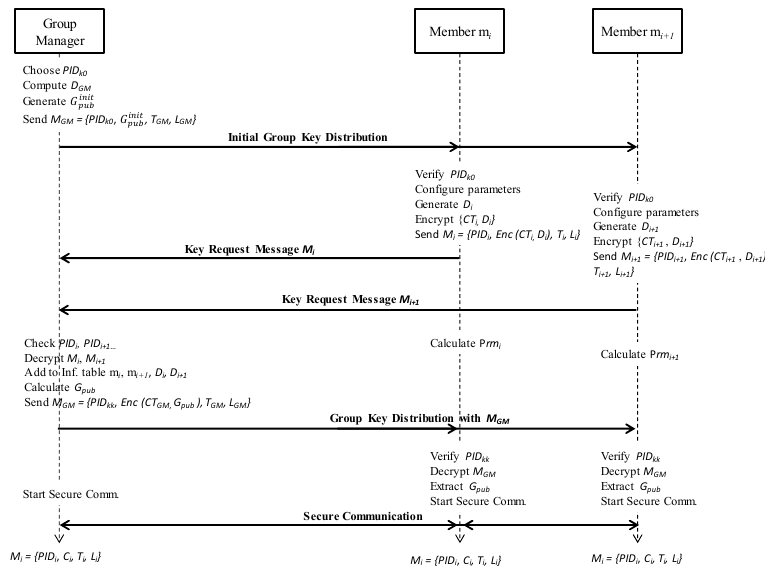
Figure 12. The workflow of the proposed solution.